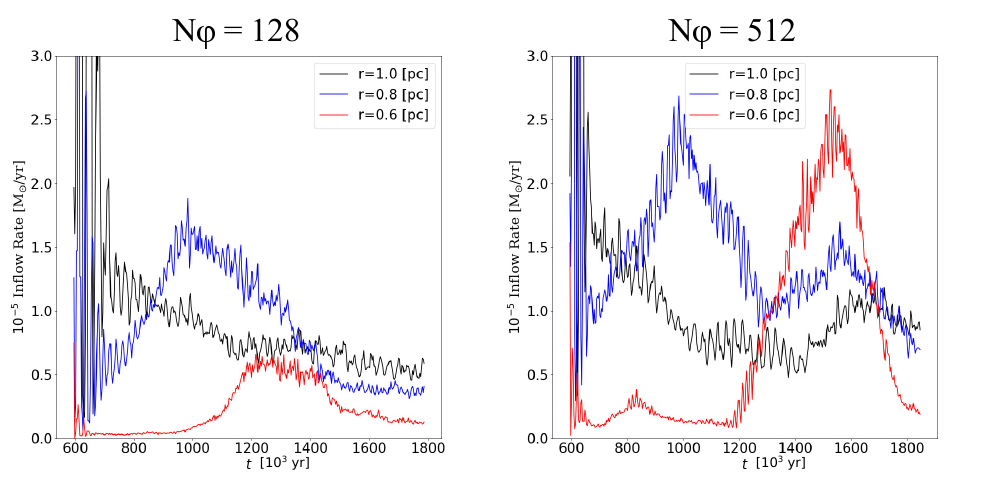
Figure 6. Inflow rate after cooling. The left panel is the model of N ϕ = 128, and the right panel is the model of N ϕ = 512. Red, blue, and black curves denote the radius of r = 0.6,0.8, and 1.0,